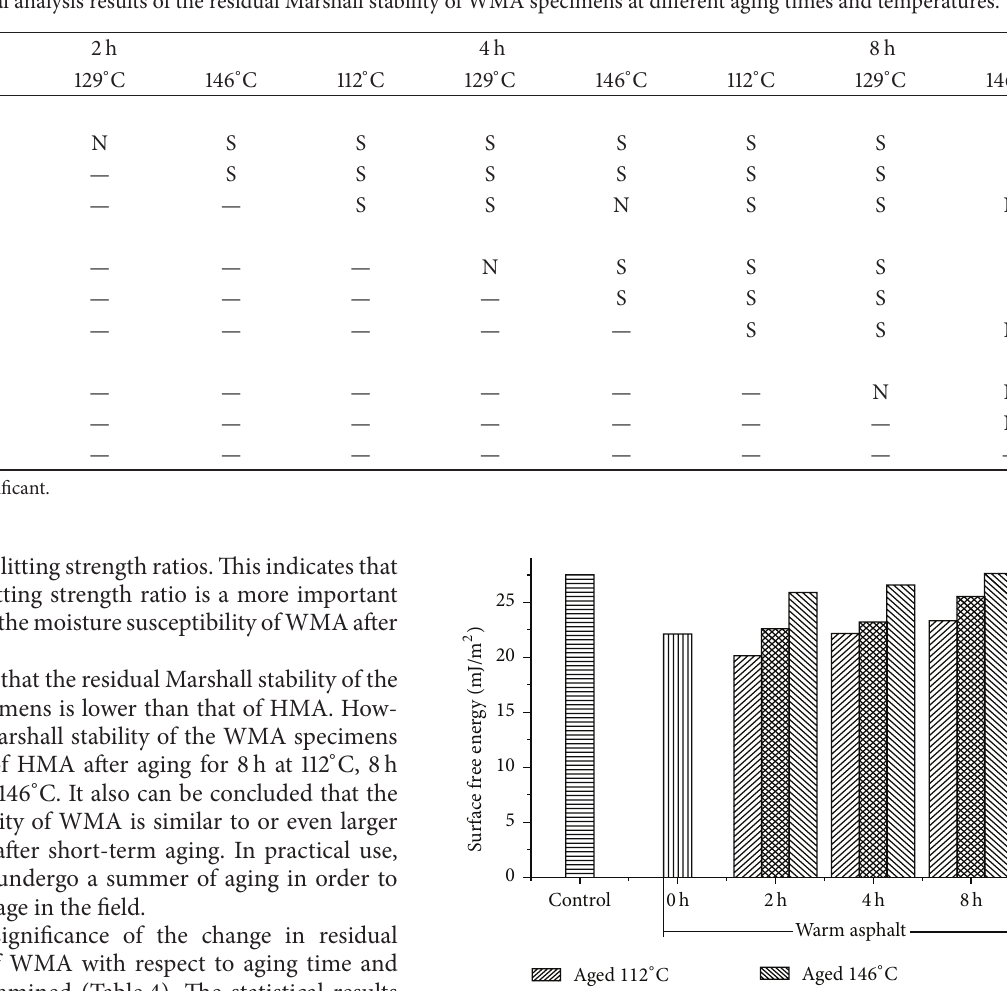
Table 4: Statistical analysis results of the residual Marshall stability of WMA specimens at different aging times and temperatures.